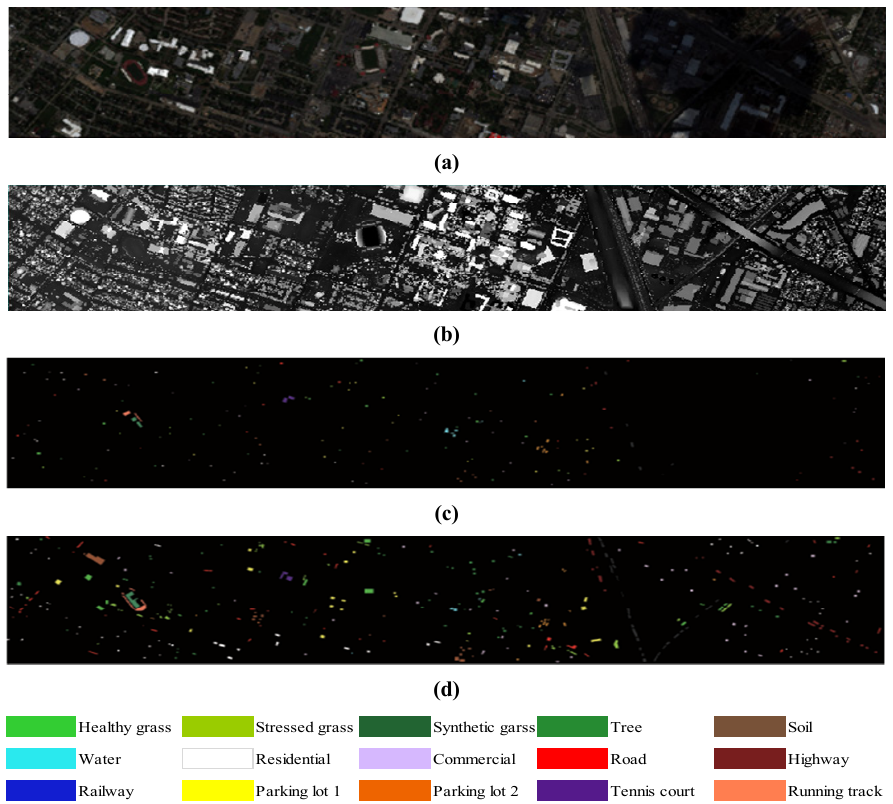
Figure 5. Houston 2013: ( a ) Pseudo-color image for HSI data. ( b ) Grayscale image for the LiDAR data, ( c ) Training data map. ( d ) Testing data map. Table 1. Sample distribution of the Houston 2013 dataset.